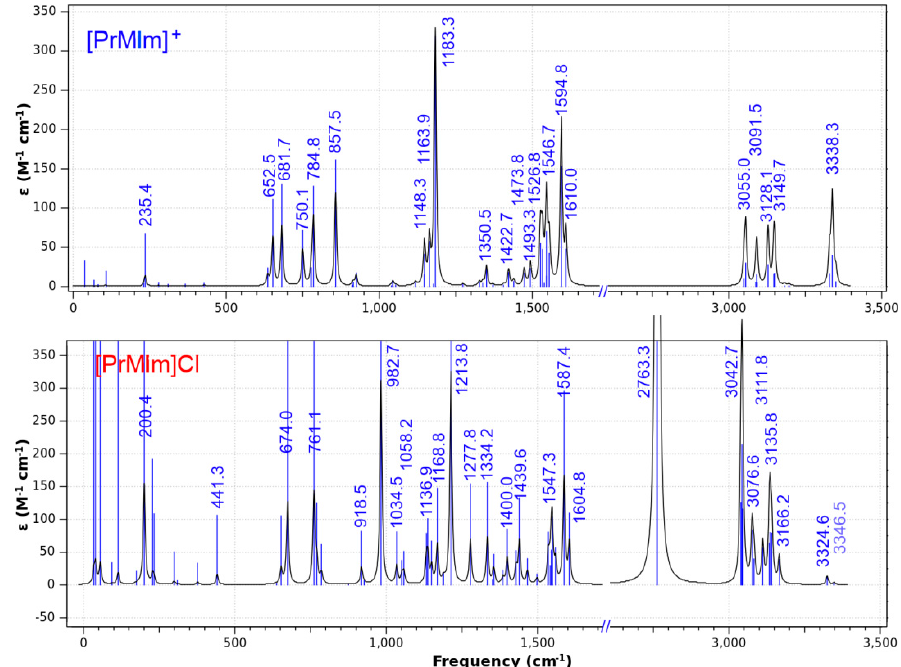
Figure 10. Infrared spectrum of the [PrMIm] + cation and the [PrMIm]-Cl structure shown in Figure 9b, as calculated via DFT. Very strong vibration modes appear in the lower panel, at 982.7 cm − 1 , 2763.3 cm − 1 and 3042.7 cm − 1 . The animation of the calculated vibrations shows that they are related to the Cl − anion. Other vibration frequencies have also showed small shift due to the influence of Cl − .